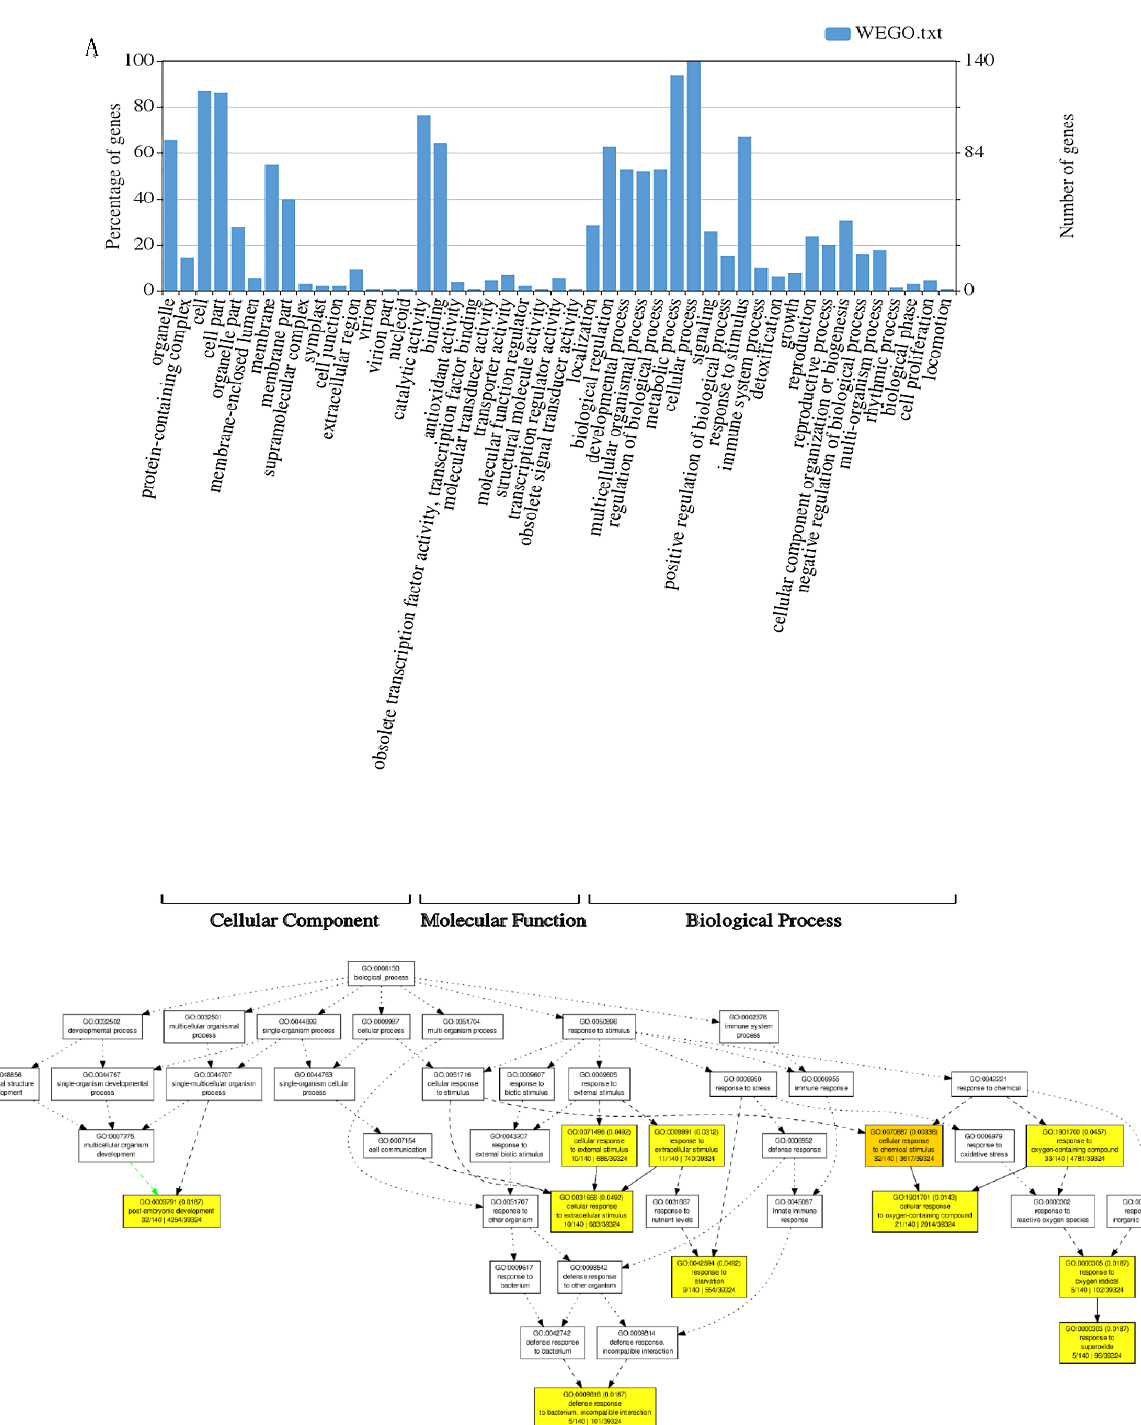
Figure 4. GO (Gene Ontology) terms related to nitrogen metabolism in candidate genes. ( A ). Histogram of GO enrichment analysis results; ( B ). DAG chart reflecting the upper and lower levels of GO term and the degree of enrichment.